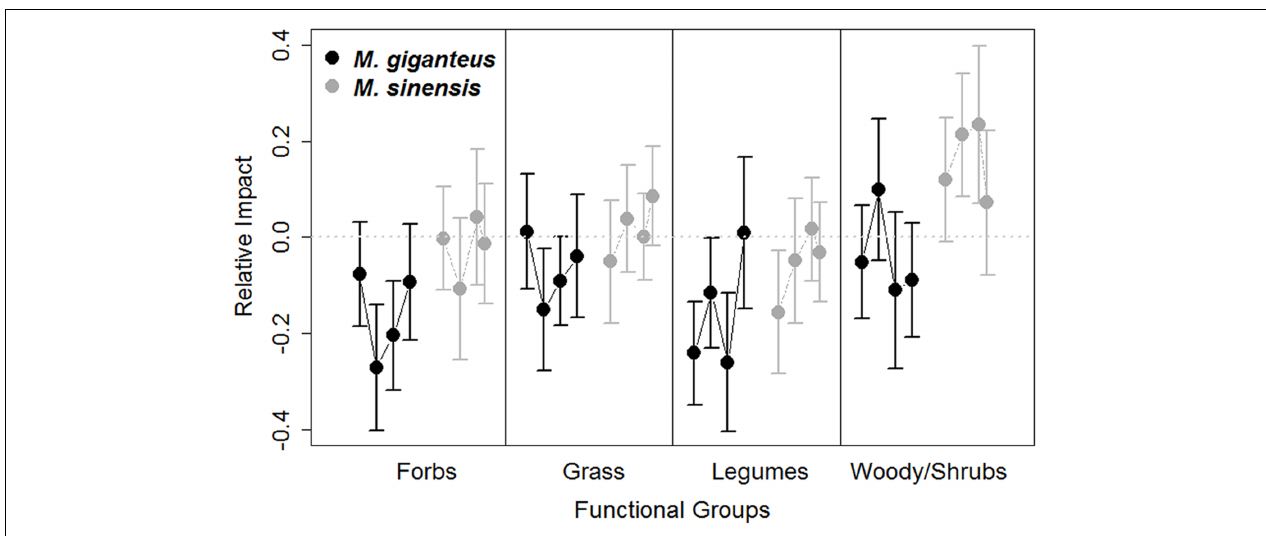
FIGURE 5 | Relative impact (RI, Mean ± SE) of Miscanthus introduction on the proportion abundance of functional group cover in M. giganteus (black) and M. sinensis (gray) plots each year from 2011 to 2014. Each dot represents consecutive single year values, connected by lines for each species. The gray dotted line indicates RI value of 0, indicating no impact. Positive RI values indicate increasingly negative effects of the invader. Functional abundance did vary among years and between Miscanthus species, with M. sinensis displaying slightly stronger